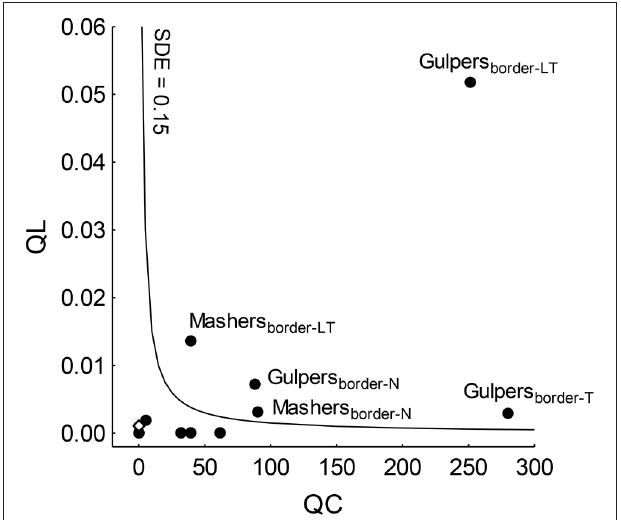
FIGURE 3 | Positions of functional groups (filled circles) of fruit-eating birds on the seed dispersal effectiveness (SDE) landscape. Subscripts show the combination of habitat-site that indicate the assemblage; T, Taficillo; N, Nogalar; LT, Los Toldos. The open diamond shows the highest QL-value reached by a functional group (i.e., mashers from Taficillo) in grasslands, where it is not possible to calculate QC. The isocline indicates the mean SDE across all functional groups.